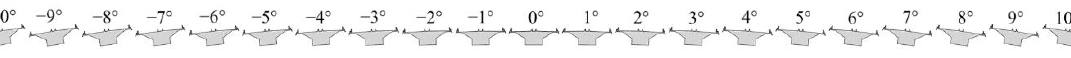
Figure 6. Rotational configurations of the bridge deck.